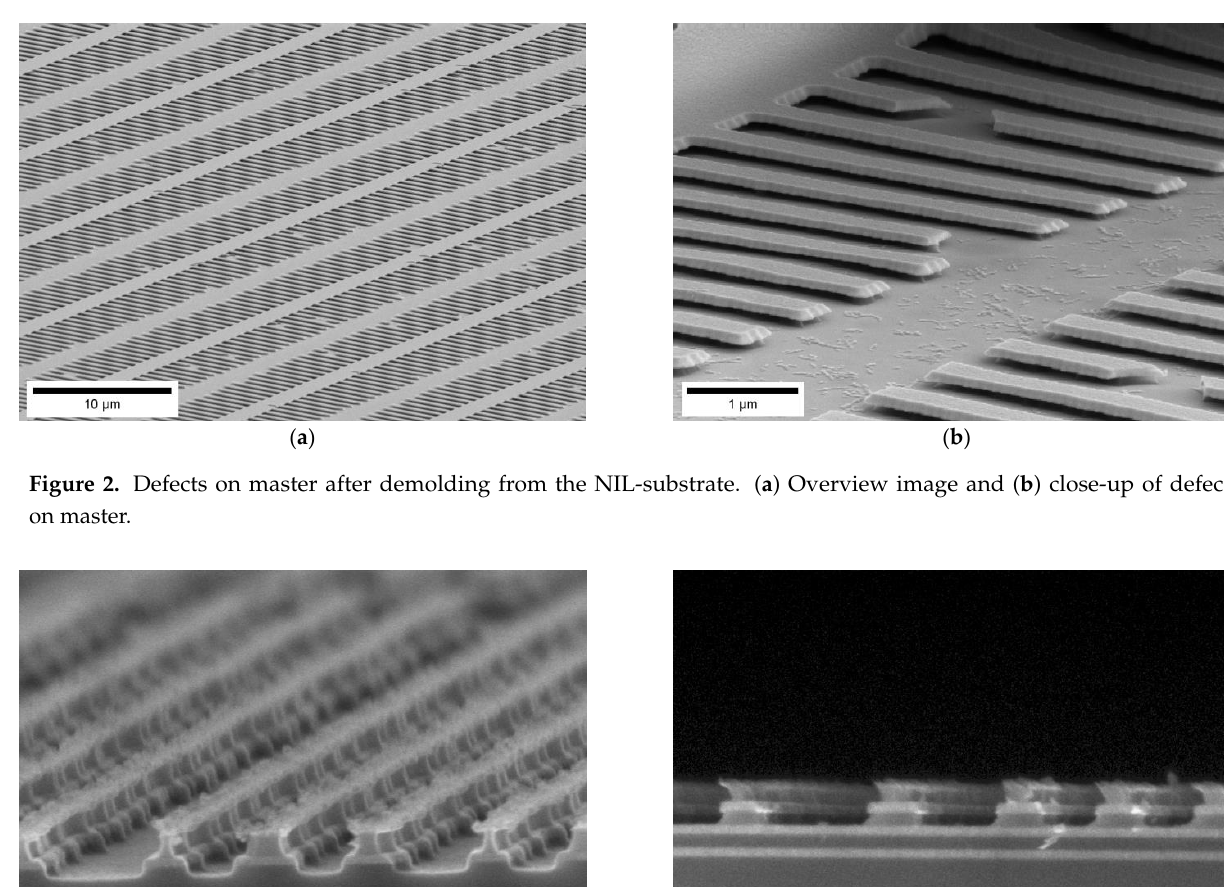
Figure 2. Defects on master after demolding from the NIL-substrate. ( a ) Overview image and ( b ) close-up of defect on master.